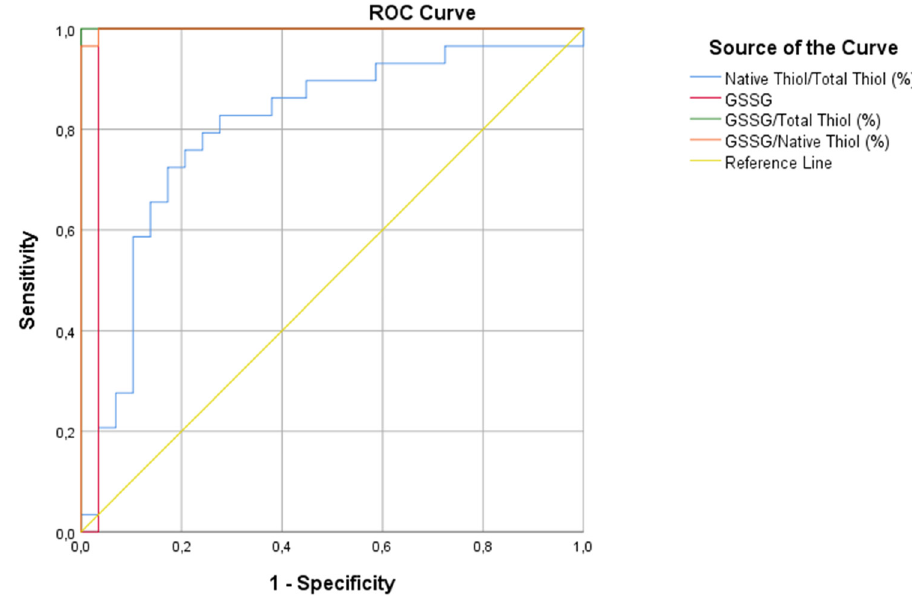
Figure 2: ROC curve of SH/TT ( % ) , GSSG, GSSG/TT ( % ) , and GSSG/SH ( % )